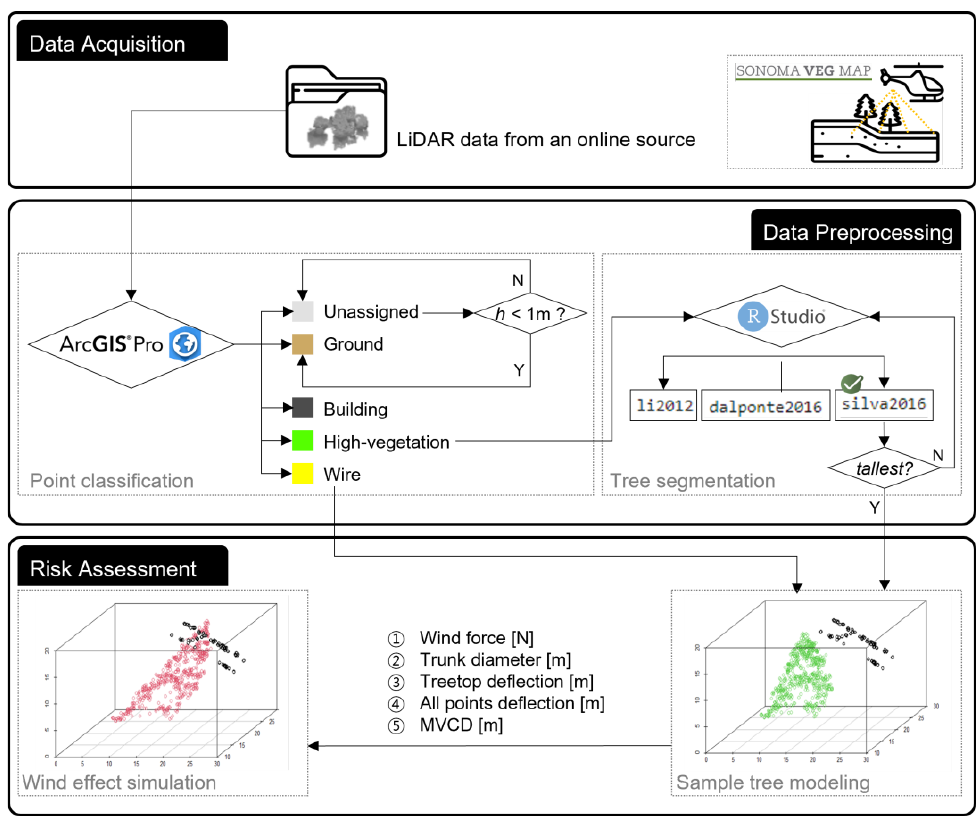
Figure 2. Overview of the proposed method.